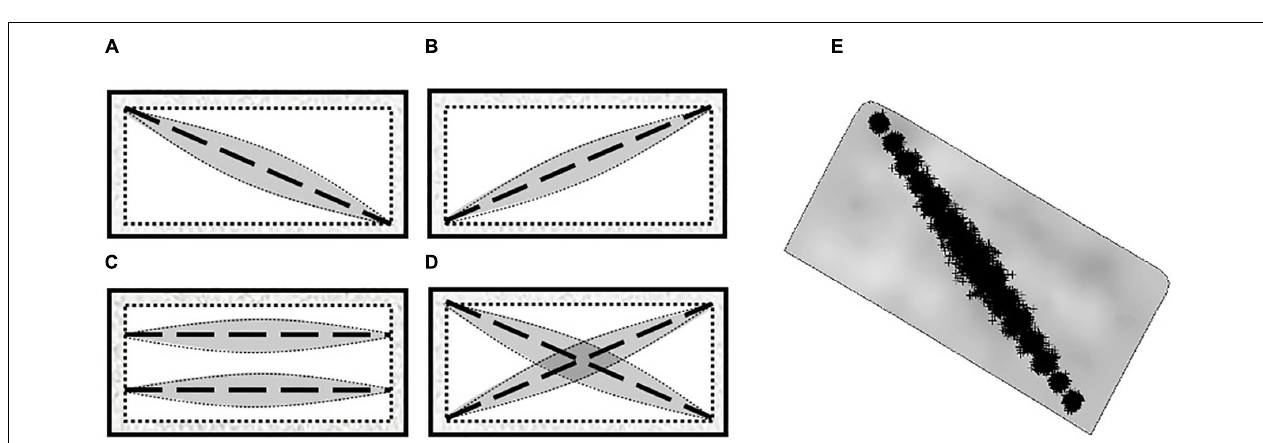
FIGURE 1 | Predicted soil organic carbon (SOC) maps of the three fields. SOC was estimated on a grid of 1 × 1 m by kriging.